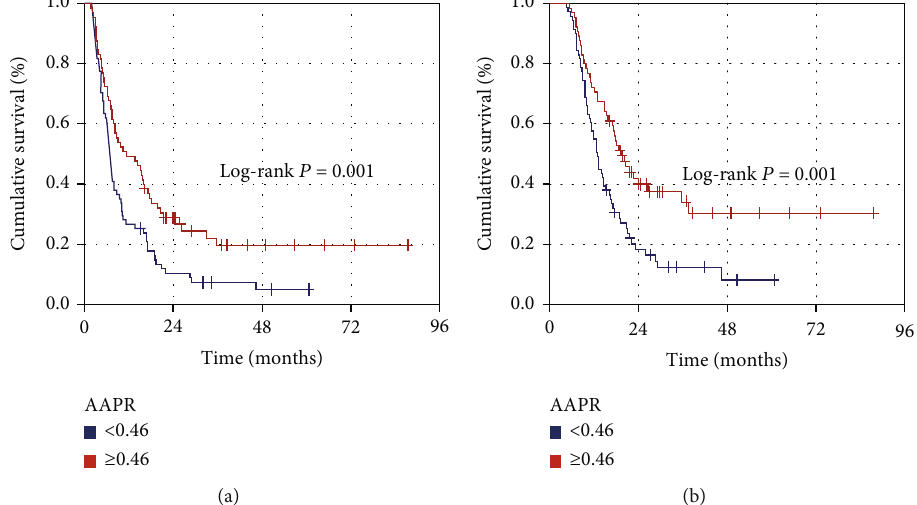
Figure 2: Survival outcomes per albumin-to-alkaline phosphatase ratio (AAPR): (a) progression-free survival and (b) overall survival (red line: AAPR ≥ 0 : 46 ; blue line: AAPR < 0 : 46